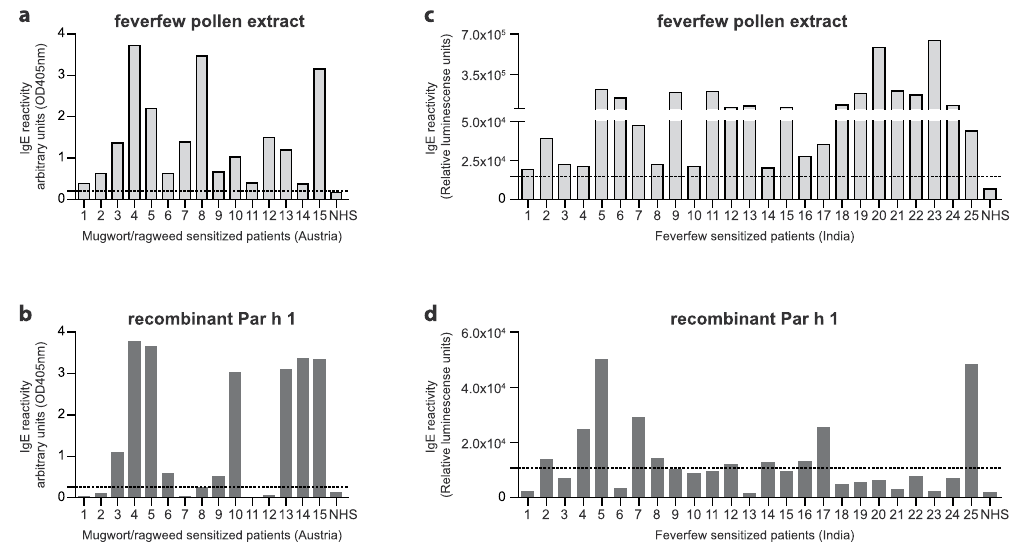
Figure 4. Feverfew extract and recombinant Par h 1 are recognized by patients’ sera in ELISA. IgE reactivity to immobilized feverfew pollen extract and purified recombinant Par h 1 was assessed with individual patients’ sera from Austria ( a , b ) and India ( c , d ). NHS, non-atopic human sera (n = 3). The dotted line indicates the response threshold calculated as 5 * SD of the buffer control